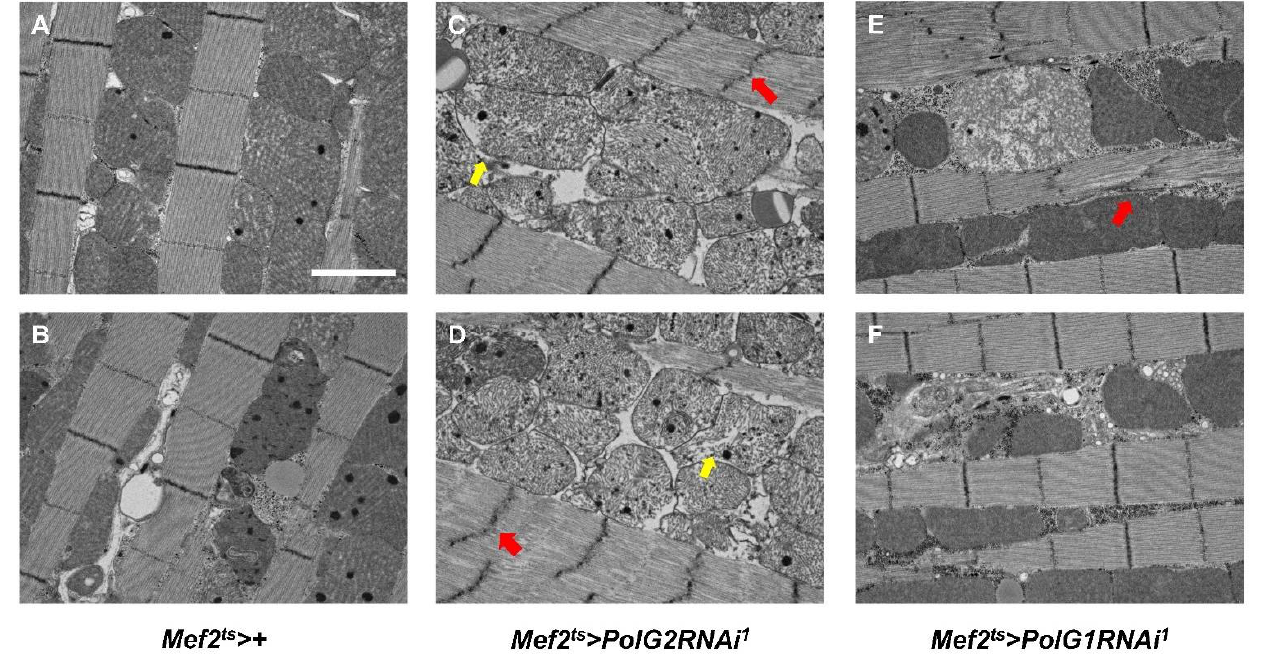
Figure 7. Transmission electron microscopy observation of indirect flight muscles from aged flies harboring continuous muscle-specific Pol γ RNAi . ( A – F ) Observation of the myofibrils and mito- chondria in the indirect flight muscles (IFMs) of 36-day-old control adults by transmission electron microscopy (TEM). ( A , B ) IFM cells from control adults ( Mef2 ts > + ) and ( C , D ) those from adults har- boring muscle-specific PolG2RNAi ( Mef2 ts > PolG2RNAi 1 ) ( C ) and PolG1RNAi ( Mef2 ts > PolG1RNAi 1 ) ( D ) were observed. Distorted Z-lines in the myofibrils of the Pol γ RNAi IFMs were frequently ob- served (red arrows) in Mef2 ts > PolG2RNAi 1 ( C , D ) and Mef2 ts > PolG1RNAi 1 ( E ). Disintegrated cristae (yellow arrows in ( C , D )) were more frequently observed in the IFMs of Pol γ RNAi adults ( Mef2 ts > PolG1RNAi 1 ). Note that the ultra-thin section shown in ( B ) is not parallel to the mitochondrial lines. Scale bar: 2 μm.